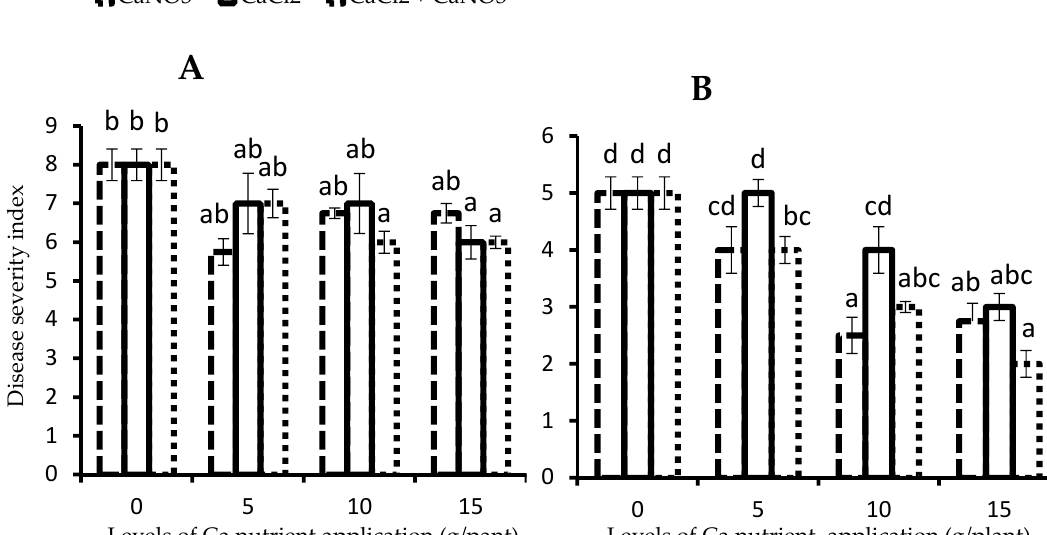
Figure 1. Severity of late blight disease in the Shenkola ( A ) and Gera ( B ) potato varieties supplied with CaNO 3 alone, CaCl 2 alone, and CaNO 3 mixed with CaCl 2 (1:1); each at 0 (control), 5, 10, and 15 g per plant. Error bar represents ± SE from four replicates. Different small letters indicate significant difference between treatments ( p < 0.05).